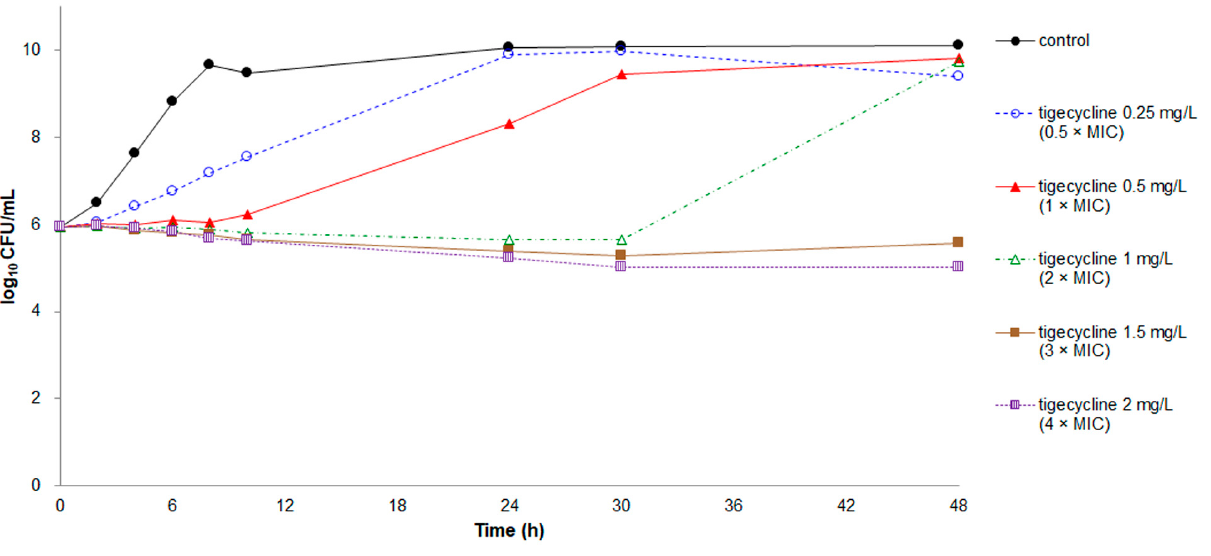
Figure 3. Time-kill assays for ciprofloxacin against E. anophelis strain ED853-49. Data points represent the mean of three experiments. MIC of ciprofloxacin = 0.5 mg/L.